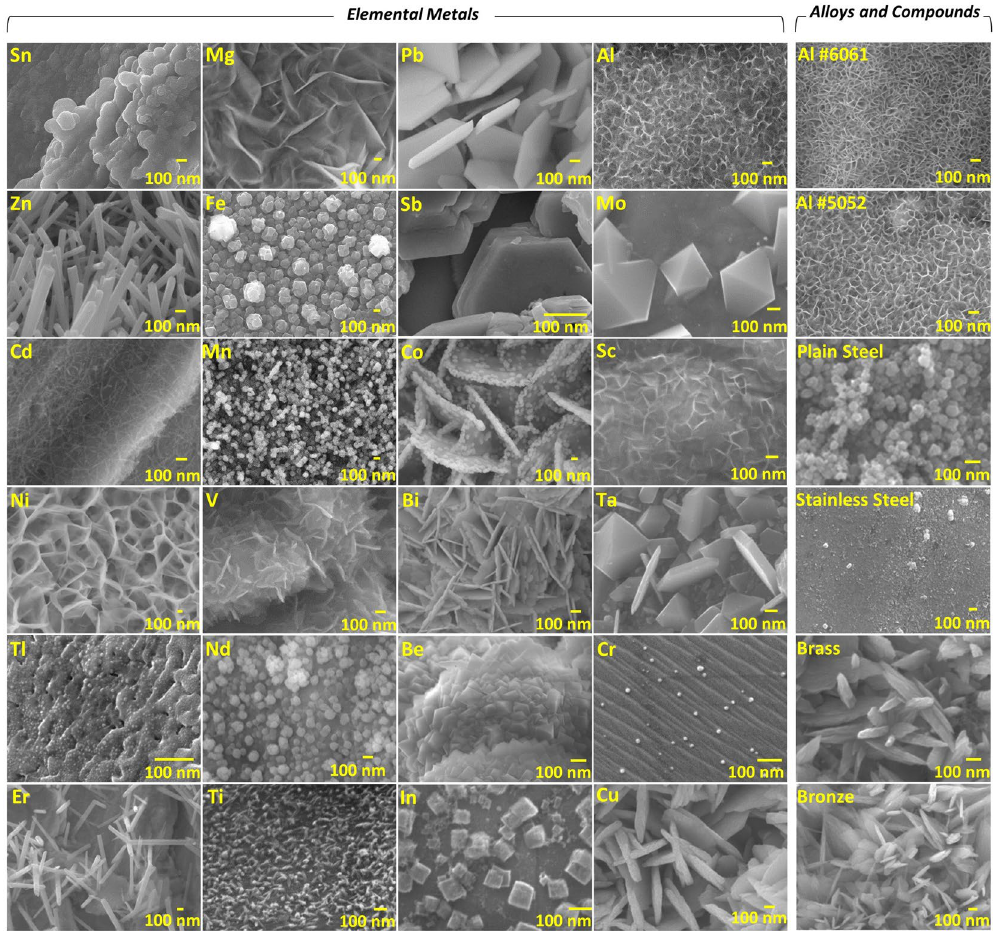
Figure 1. Top-view SEM images of various elemental metals and some alloys and metallic compounds after hot water treatment (HWT) are shown. Sequence of the images are arranged based on the treatment time required in order to form well-defined metal oxide nanostructures (MONSTRs): from shortest to the longest treatment time in the order of ( a ) from left to the right and top to the bottom ( b ) from top to the